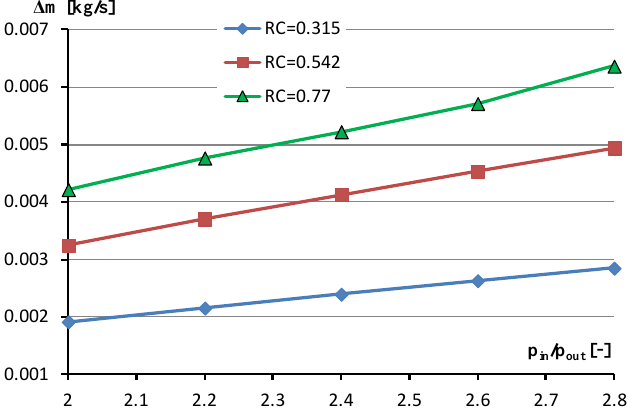
Figure 13. Leakage reduction for geometries 8t of the clearance height RC = 0.315, 0.542, and 0.77 mm depending on the pressure ratio for T in = 300 K, p out = 10 5 Pa.